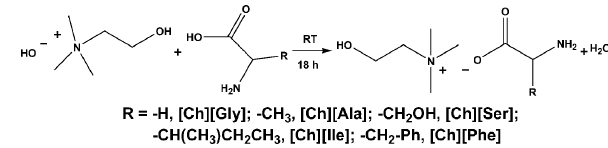
Fig. 1 General synthetic route for [Ch][AA]